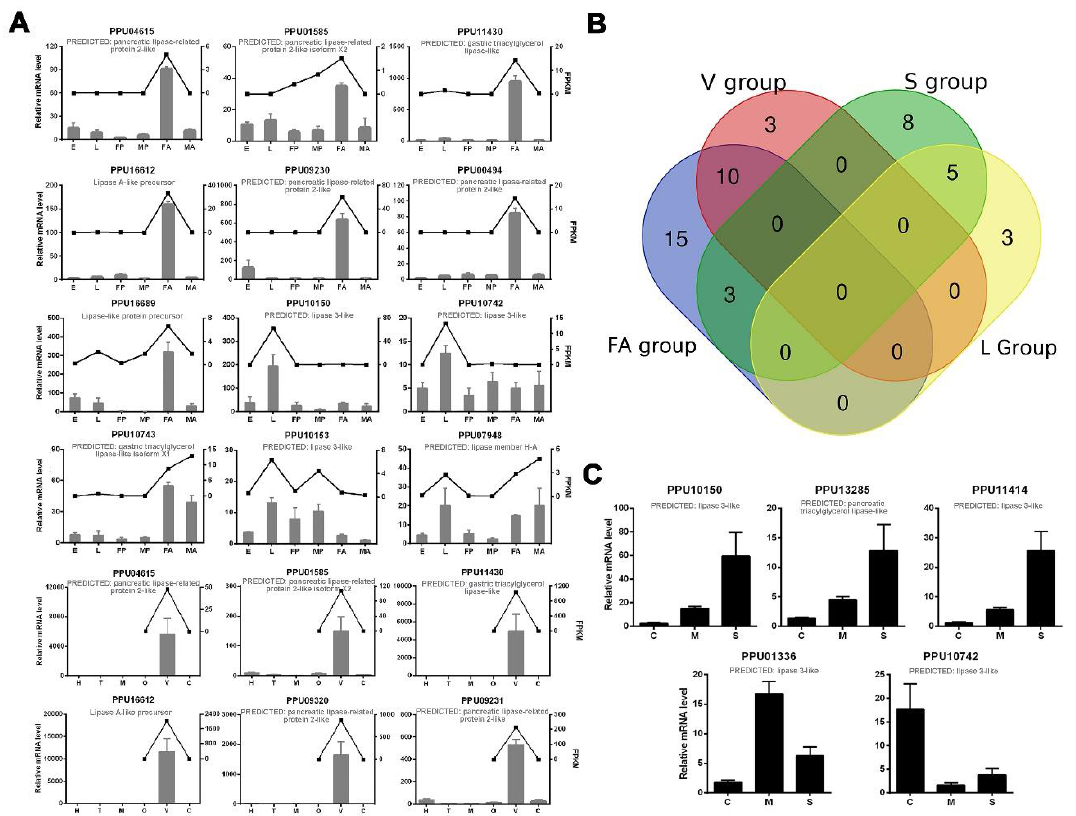
Figure 2. qPCR results of selected lipase genes in P. puparum . ( A ) Total RNA extracted from P. puparum across different developmental stages and female tissues were used to perform qPCR. Lines display the FPKM values in transcriptome analysis, corresponding to the Y-axis at right. qPCR results of the selected lipases were mostly in accord with the transcriptome data. E = eggs, L = larvae, FP = female pupae, MP = male pupae, FA = female adults, MA = male adults, H = heads, T = thoraxes, M = midguts, O = ovaries, V = female venom glands, C = carcass (female adults without venom glands). ( B ) Venn diagram of potential venom lipases and salivary lipases. The blue circle indicates the lipases with especially high expression in female adults (FA group), the red circle indicates lipases with especially high expression in venom glans (V group), the green circle indicates lipases with especially high expression in larval salivary glands (S group), and the yellow circle indicates lipases with especially high expression at the larvae stage (L group). ( C ). Total RNA was extracted from the larval tissues of P. puparum . C = carcass, M = midguts, S = salivary glands; 18s rRNA of P. puparum was used as a housekeeping gene. Error bars represent the standard errors of the mean from three biological replicates.